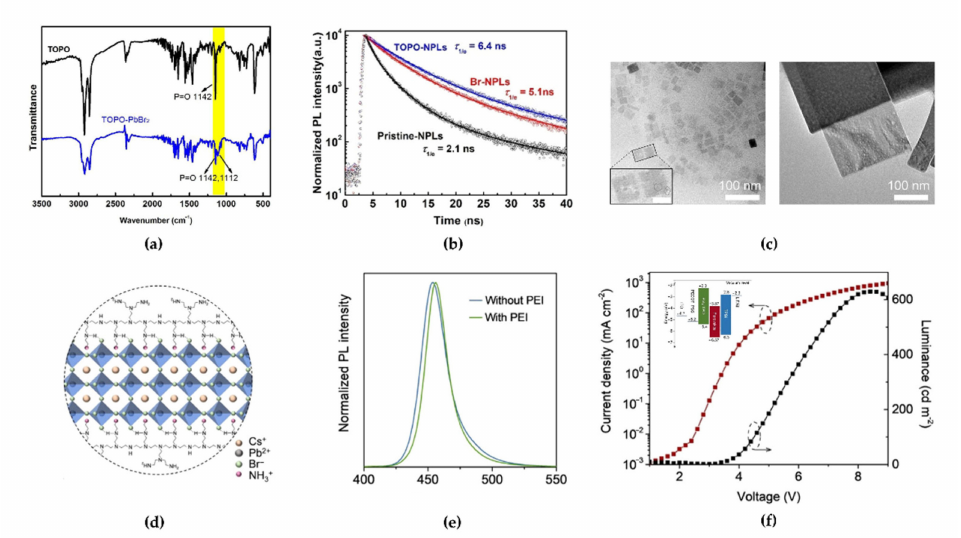
Figure 13. ( a ) The FTIR spectra of pure trioctylphosphine oxide (TOPO) and TOPO-PbBr 2 adduct. Reprinted with permission from [87], Copyright 2020 American Chemical Society. ( b ) PL decay curves of pristine-NPL, Br-NPL, and TOPO − NPLs solutions. Reprinted with permission from [87], Copyright 2020 American Chemical Society. ( c ) Transmission electron microscopy images of CsPbBr 3 NPLs without ( left ) and with ( right ) polyethylenimine (PEI), respectively (inset: a few discontinu- ous areas within the NPLs ( left side ) and some ~2 nm nanoparticles circled in black ( right side )). Reprinted with permission from [89], Copyright 2021 American Chemical Society. ( d ) Schematic of CsPbBr 3 NPLs with PEI. Reprinted with permission from [89], Copyright 2021 American Chemical Society. ( e ) PL spectra of CsPbBr 3 NPLs with an excitation wavelength of 360 nm. Reprinted with permission from [67], Copyright 2021 American Chemical Society. ( f ) Current density (left axis) and luminance (right axis) characteristics as a function of the applied voltage in PEI–CsPbBr 3 NPL-based PeLED (inset: energy band diagram of the PEI–CsPbBr 3 NPL-based LED). Reprinted with permission from [89], Copyright 2021 American Chemical